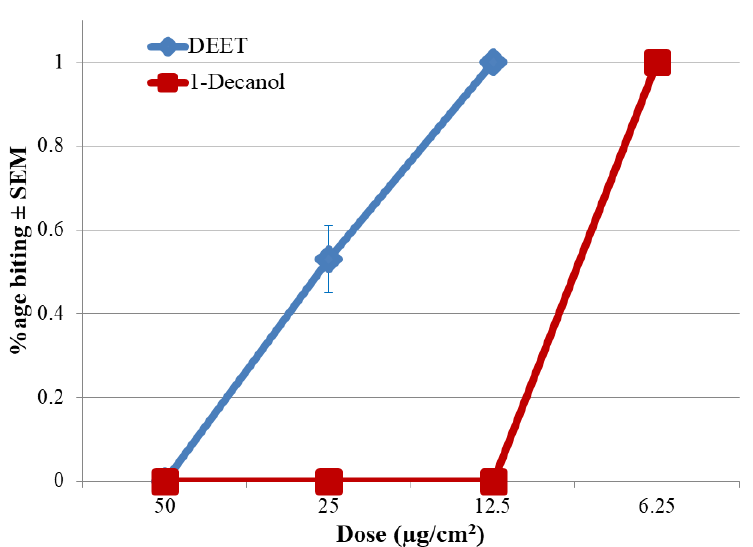
Figure 3. Data are %age (mean ± SEM) females biting. Minimum effective dosage (MED) values in this bioassay were ≤ 1% biting in 1 min which is two females out of 200 in this cage.